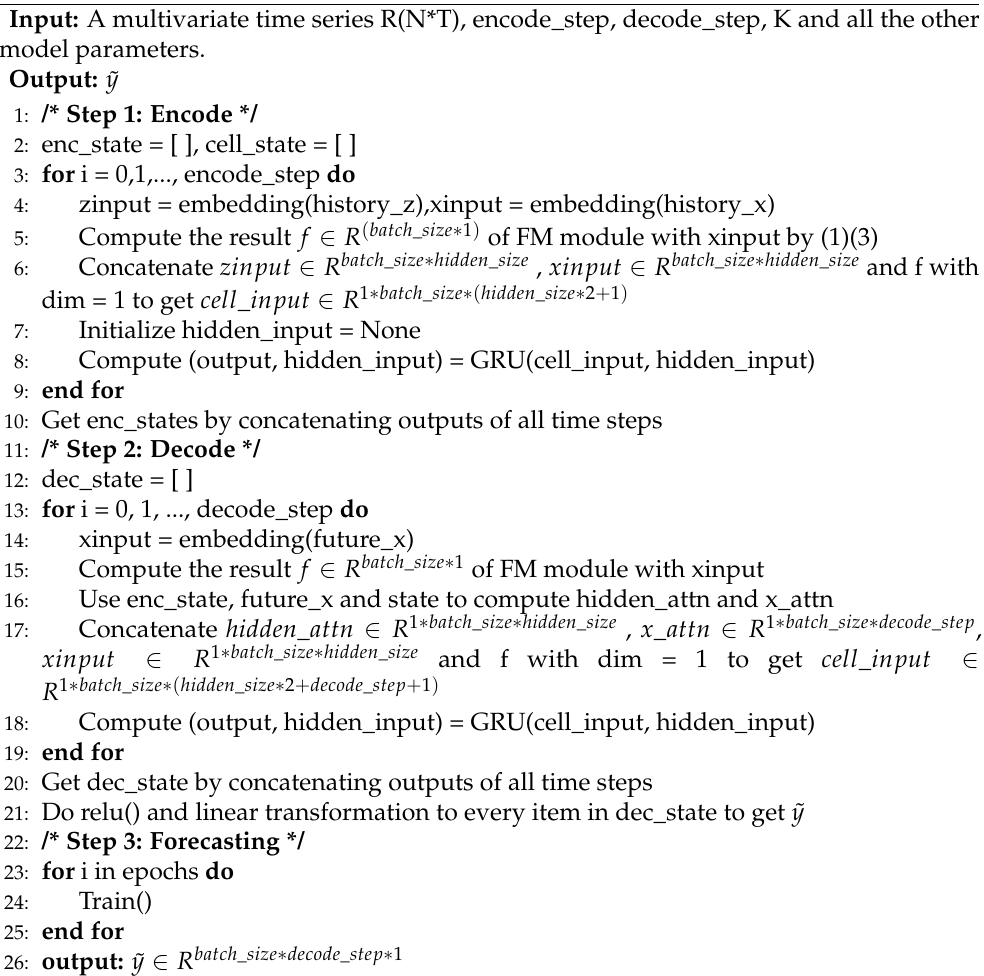
Algorithm 1 TSF using